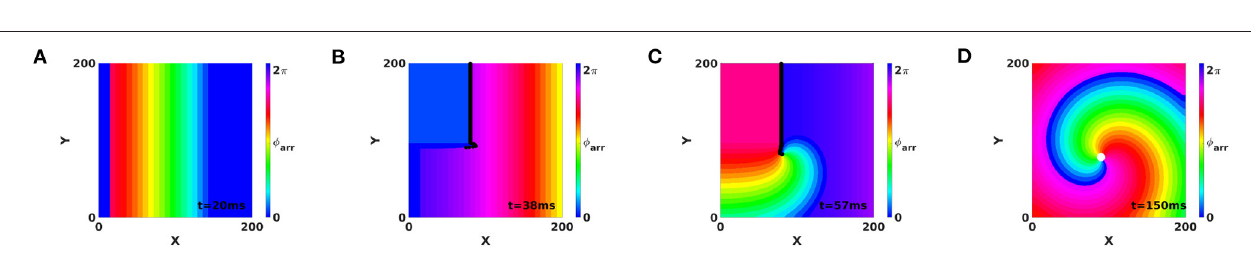
20 ms, t 38 ms, t 57 ms, and t 150 = = = =